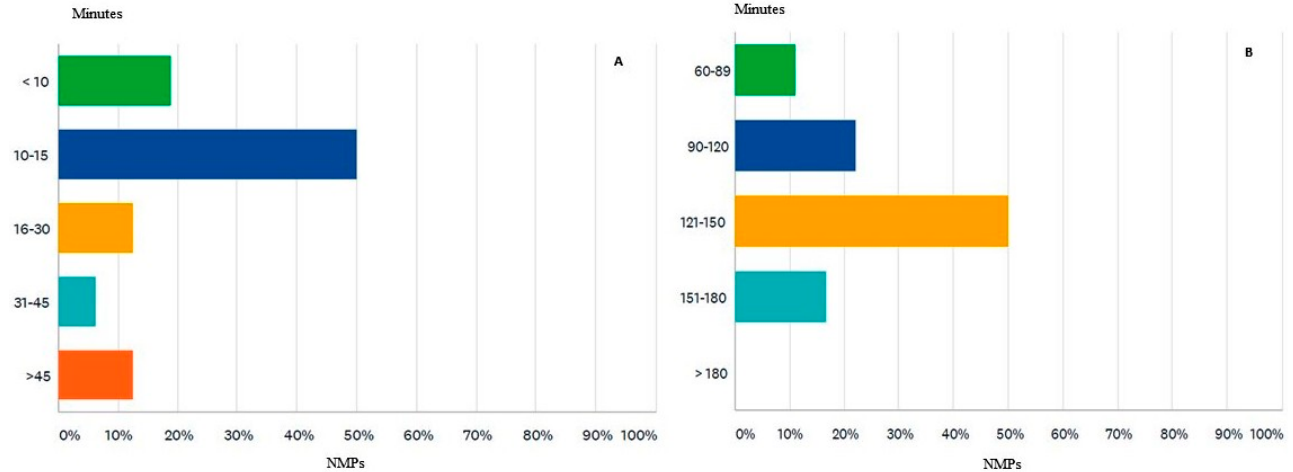
Figure 7. Time interval between the administration of 99mTc-bisphosphonate for the early ( A ) and late ( B ) acquisition.